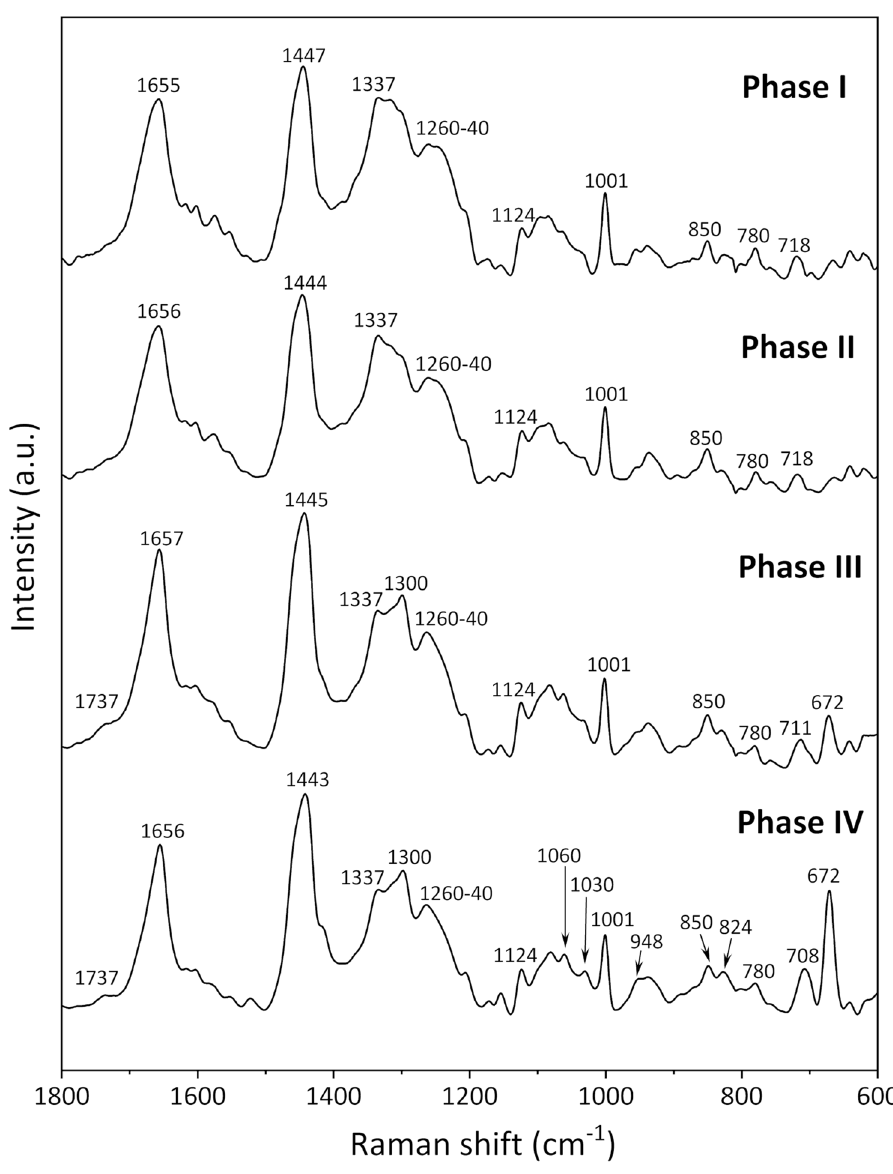
Figure 1. Mean Raman spectra in the 1800–600 cm −1 region for fixed iPSCs obtained for Phases I, II, III,